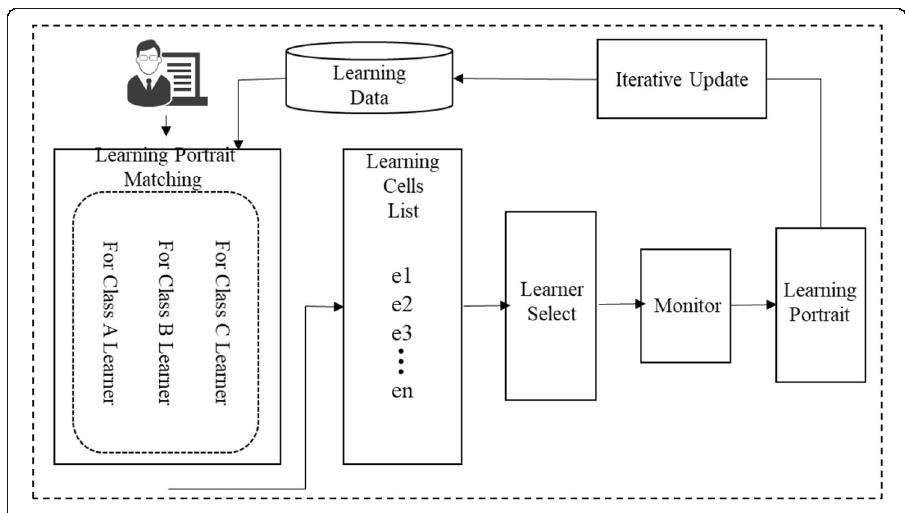
Fig. 7 The flow of the generative paths